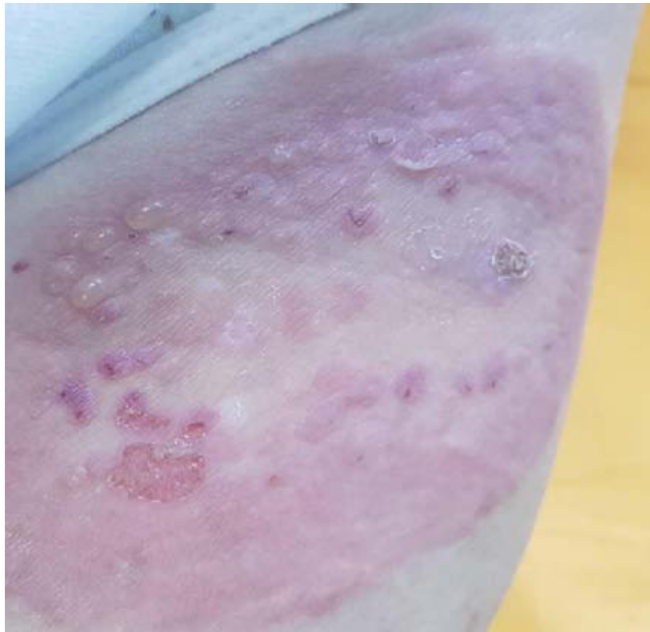
Figure 6. Pemphigoid gestationis: cutaneous bullous lesions on the upper thigh of a third trimester pregnant patient (courtesy of Prof. Călin Giurcăneanu) .